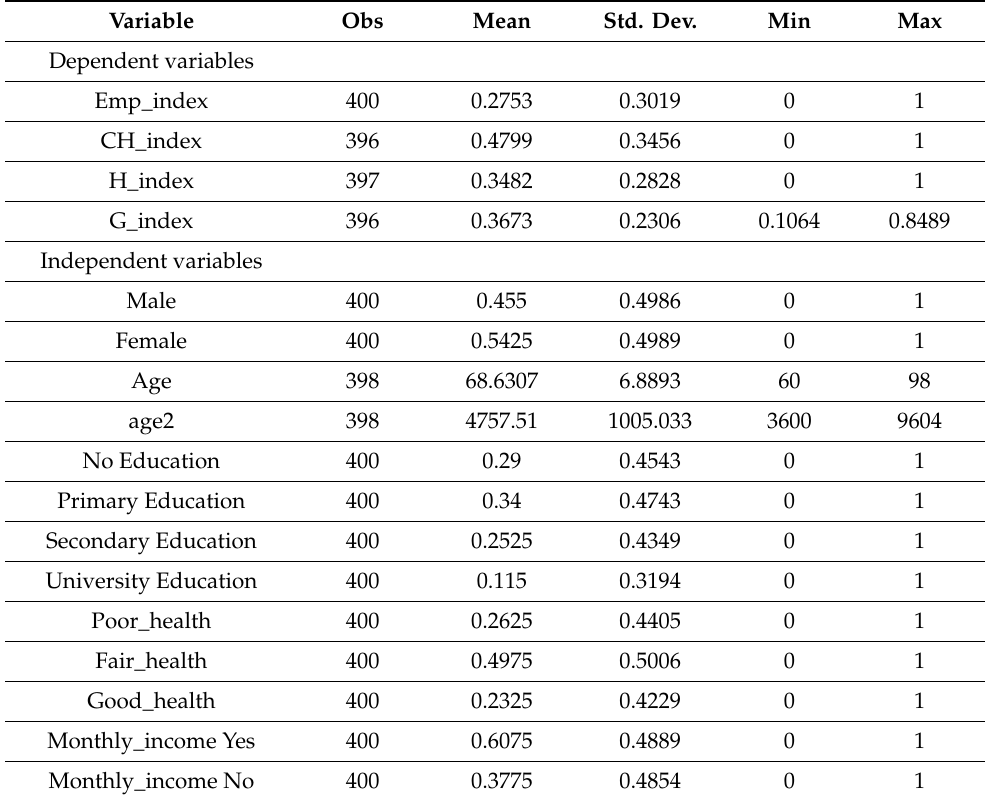
Table 6. Active ageing indices (descriptive